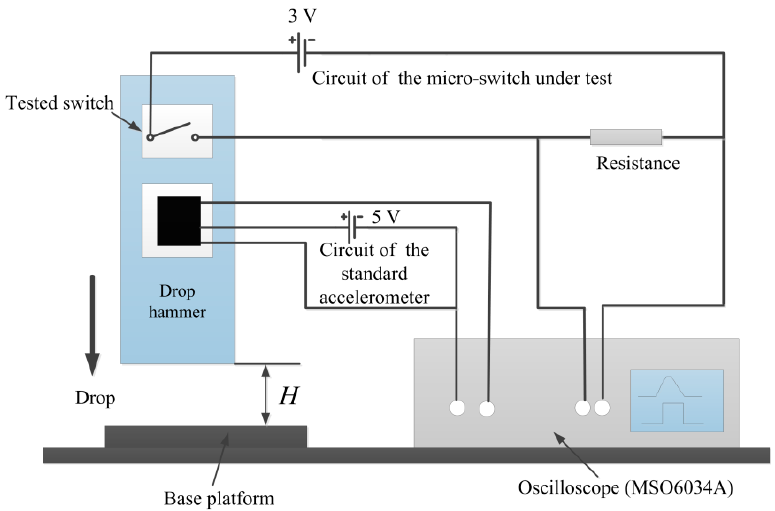
Figure 15. Schematic diagram of the tested setup for the fabricated microswitch.